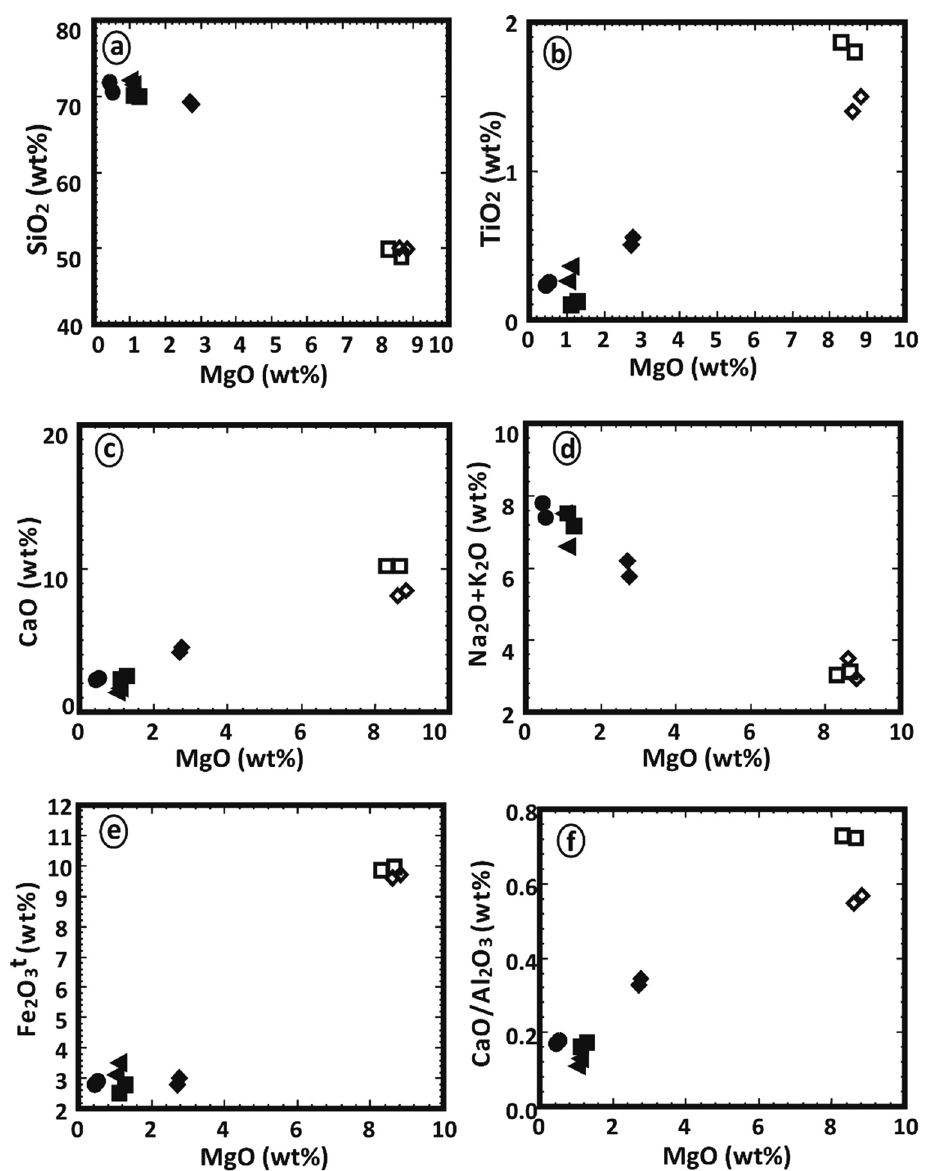
Figure 6: MgO vs ( a ) SiO 2 , ( b ) TiO 2 , ( c ) CaO, ( d ) Na 2 O + K 2 O, ( e ) Fe 2 O 3 , and ( f ) CaO/Al 2 O 3 for di ff erent dikes; symbols as in Figure